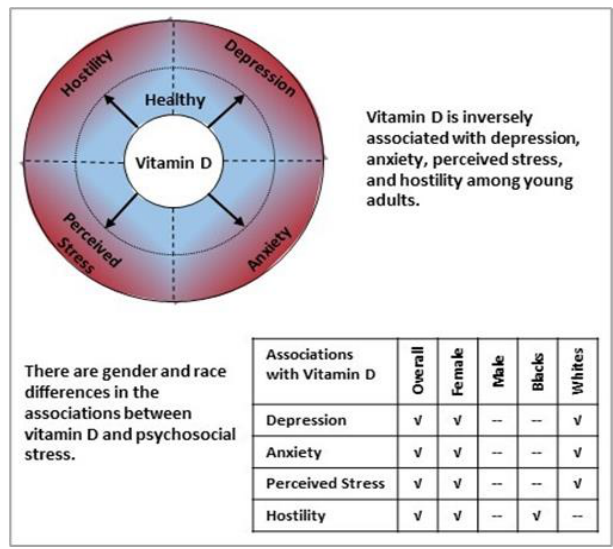
Figure 1. Summarization of the key findings.